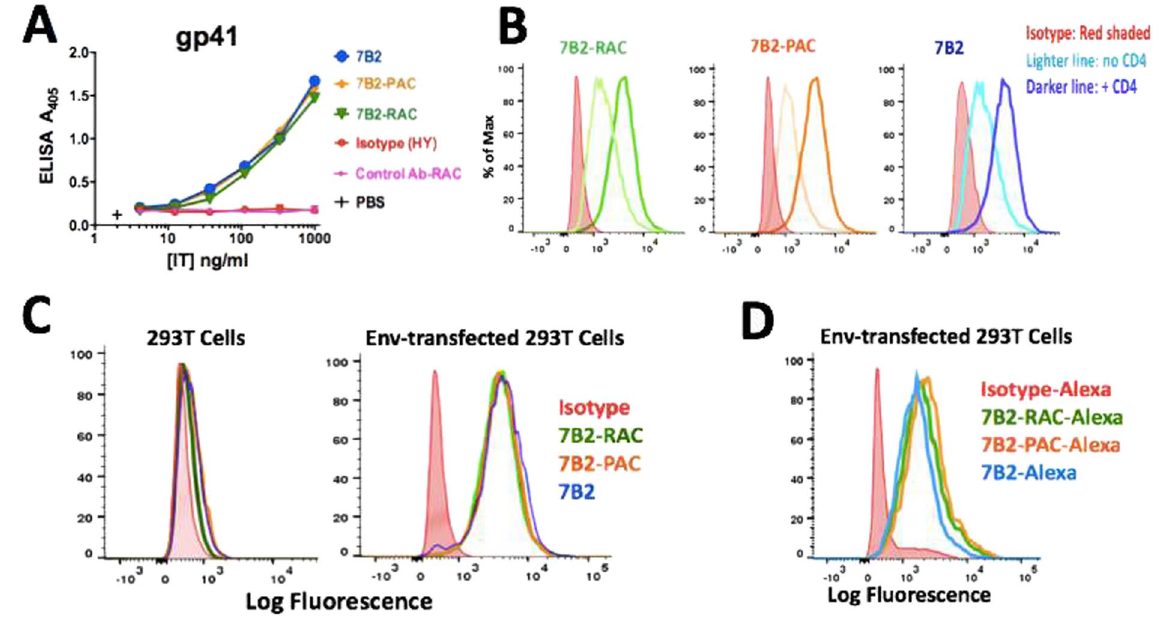
Figure 3. Binding ability of 7B2 based-ITs to gp41 antigen by using ELISA and flow cytometry. ( A ) ELISA plates coated with gp41 Ag, as a peptide representing 7B2 ′ s epitope. Binding of the 7B2 based-ITs is detected by AP-conjugated goat anti-human IgG. Results are representative of means of triplicate values with three individual experiments. ( B ) Using FITC-secondary immunofluorescence, we detect binding of ITs to Env- transfected 293 T cells in the presence ( darker line ) or absence ( lighter line ) of sCD4 (CD4-183). Isotype control is shown as red shaded histogram. ( C ) IT binding to 293 T cells and transfected 293 T cells with 92UG037.8 gp160 (293 T/92UG) was detected by using FITC-secondary immunofluorescence. Results are representative of at least three independent experiments. ( D ) The flow cytometry histogram of Alexa488- labeled ITs by using Env-transfected 293 T cells incubated in PBS + 1% BSA + sodium azide (0.2%). Results are representative of three individual experiments. Isotype control (chimeric RAC18-alexa488) is shown as red shaded